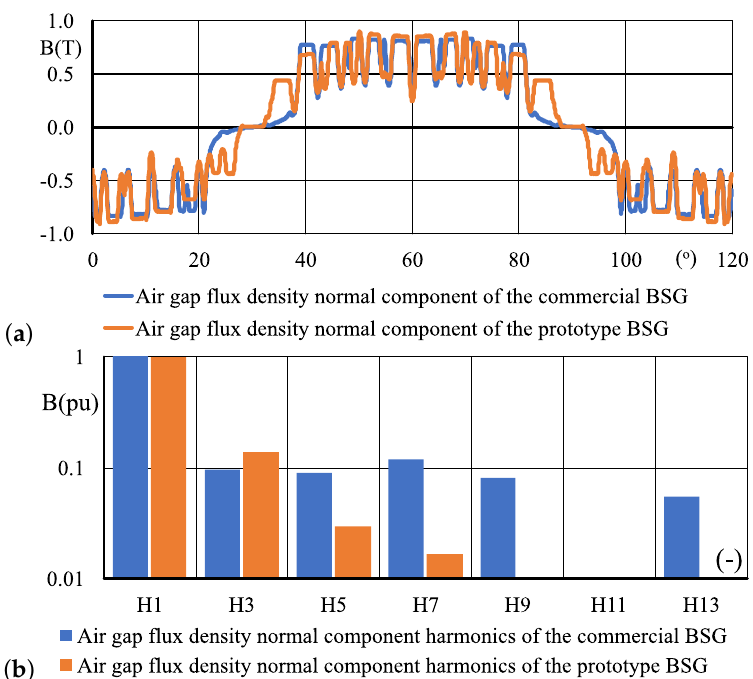
Figure 8. FEM simulation results at no-load conditions—air gap flux density normal component distribution (0.8T—amplitude of the fundamental component): ( a ) commercial salient pole and prototype air gap flux distribution BSG; ( b ) harmonic components of air gap flux distribution.